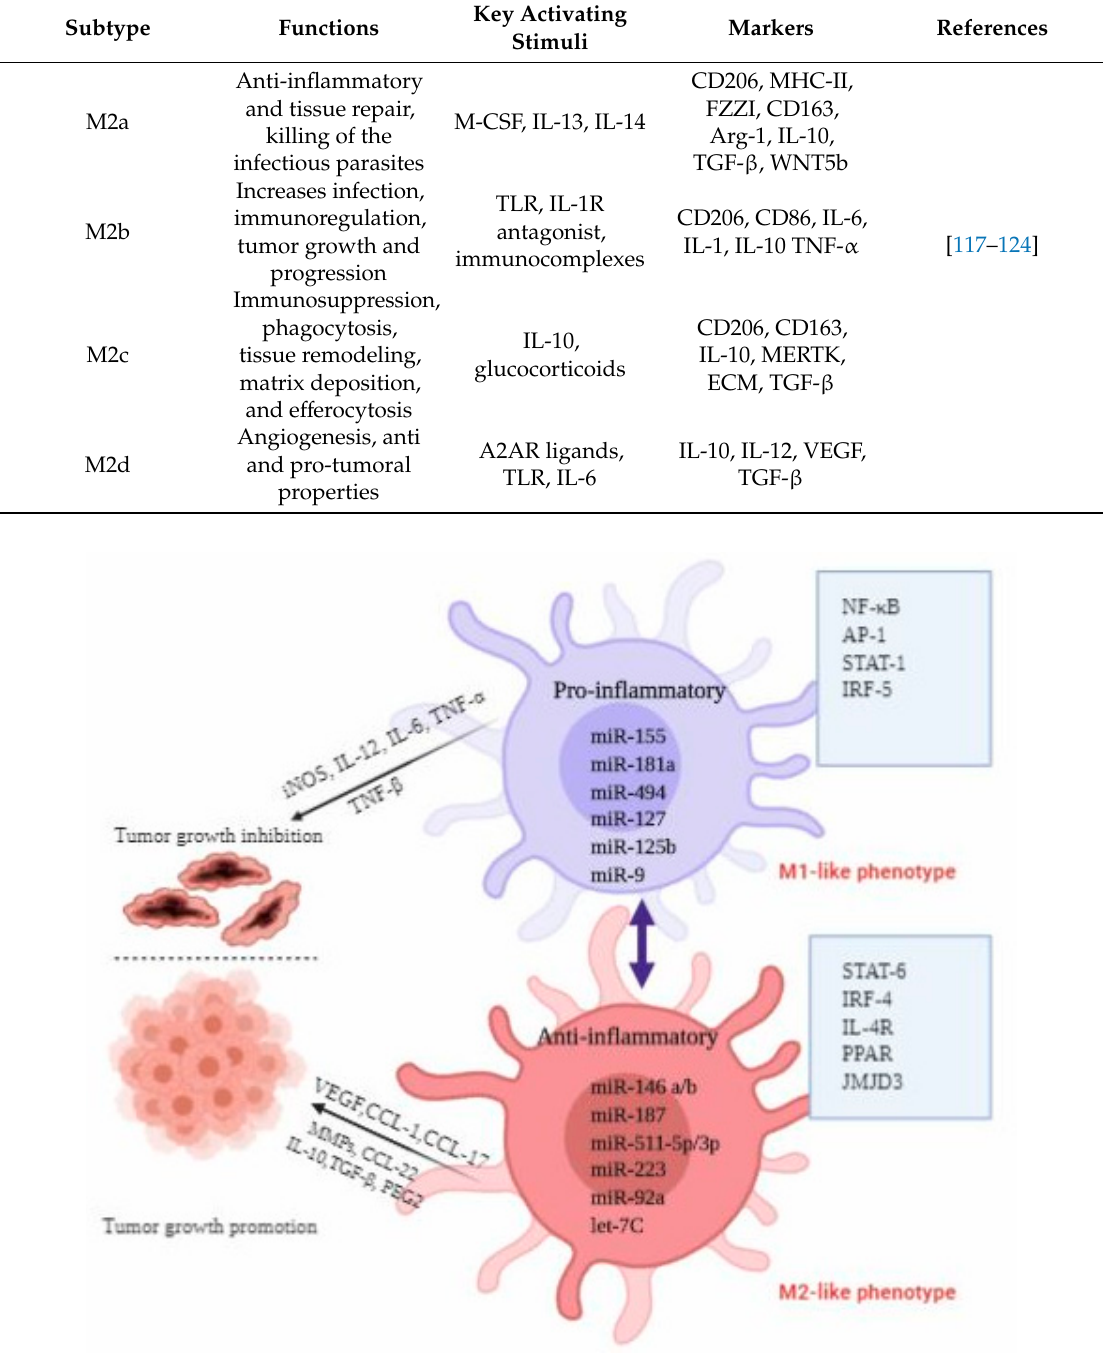
Table 2. Classification of M2-like macrophages.